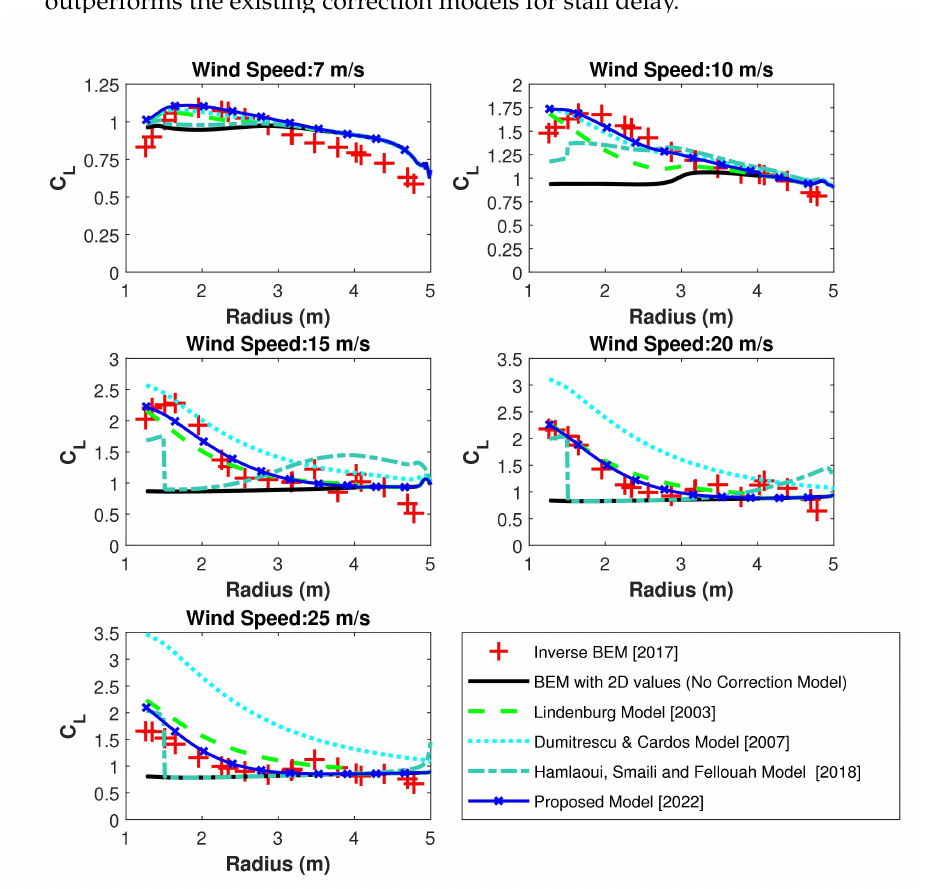
Figure 8. Contrast of evaluated C L throughout the blade length from BEM analysis without and with different correction models for stall delay and Inverse BEM method for NREL Phase VI